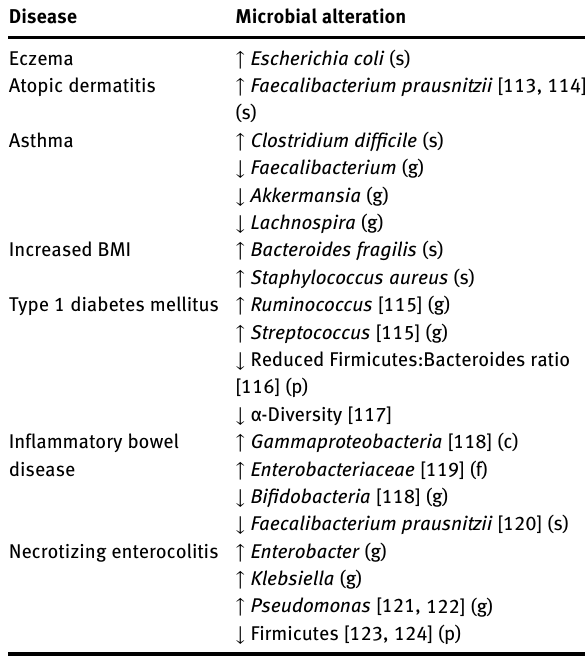
Table  : Diseases associated with early life dysbiosis.